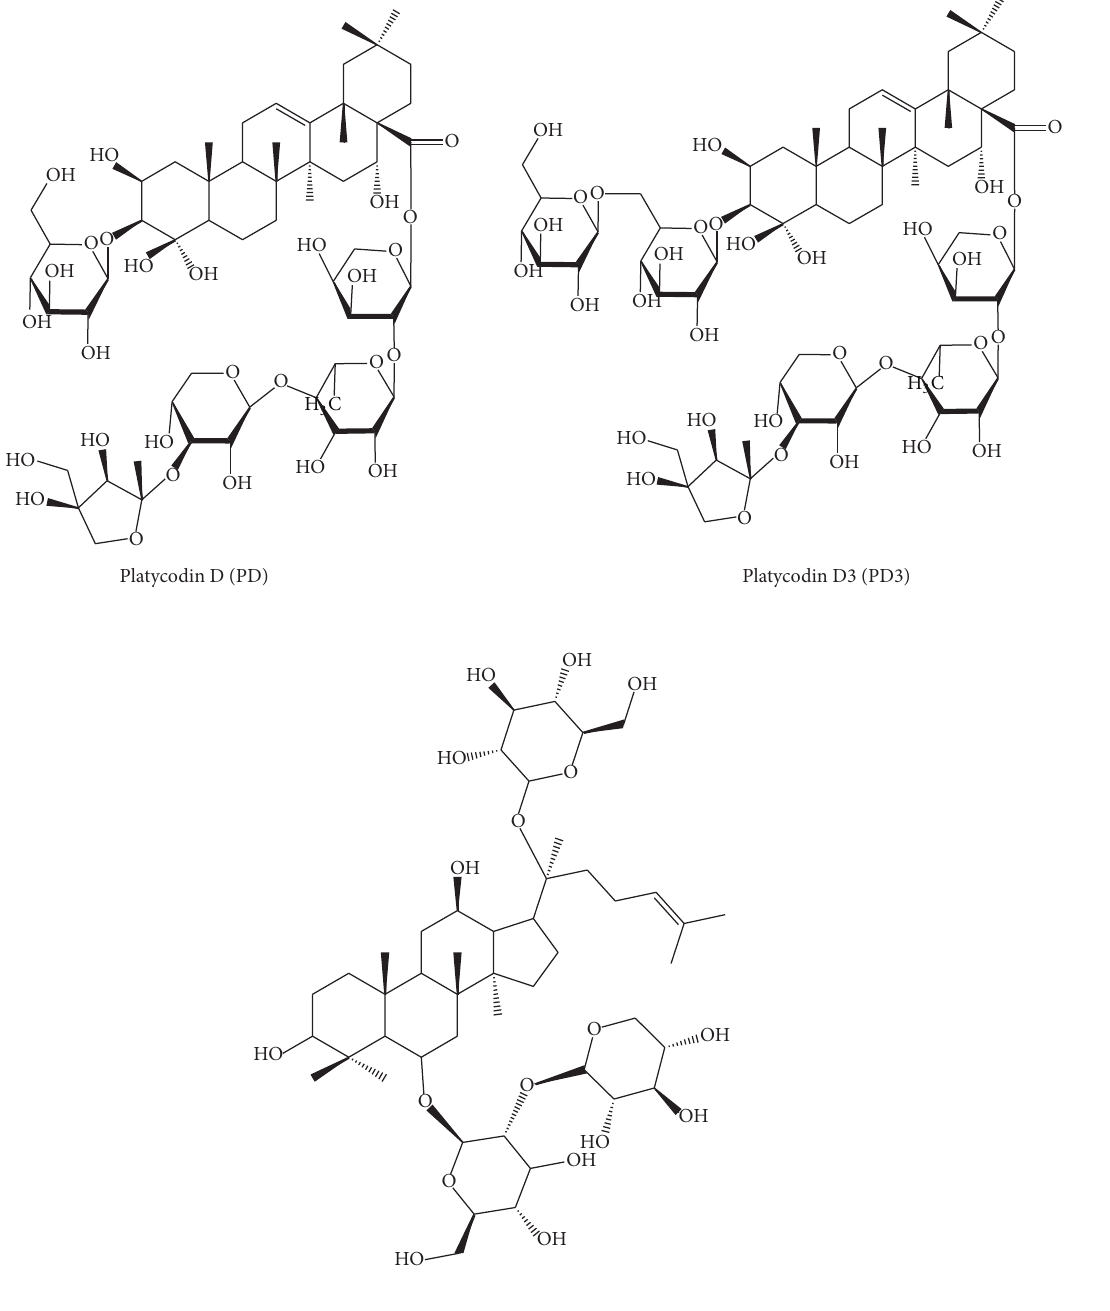
Figure 1: Chemical structures of platycodin D (PD), platycodin D3 (PD3), and notoginsenoside R1